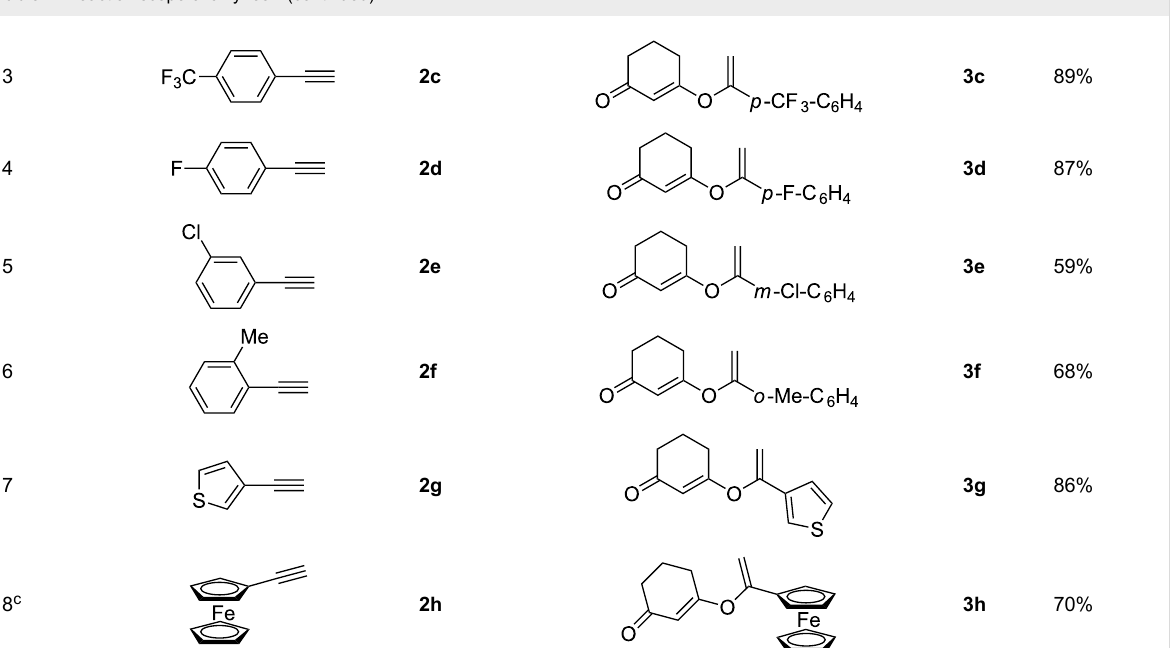
Table 2: Reaction scope of alkynes. a (continued)